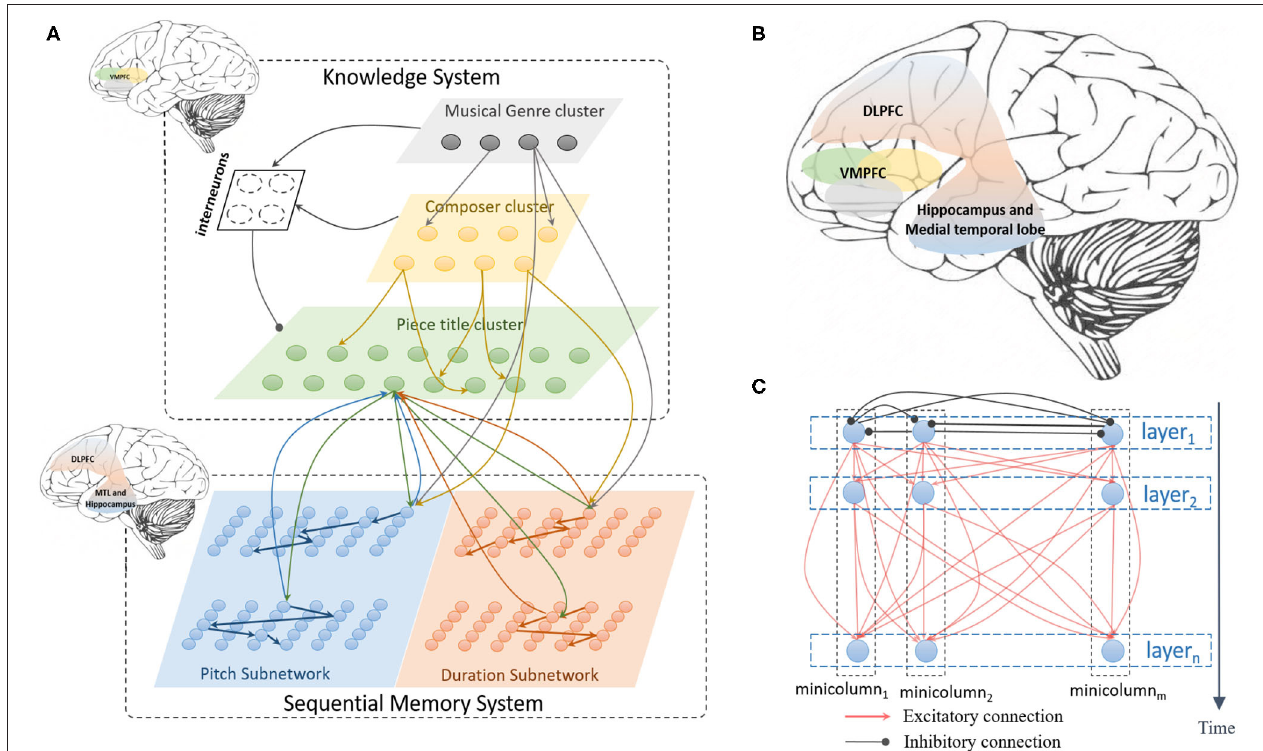
FIGURE 1 | The architecture of the model, (A) describes the total architecture of the model, it contains knowledge and sequential memory subsystems, each subsystem is composed several areas which are inspired by relative brain regions marked in left top, (B) shows the main brain areas related in human memory and creativity, (C) draws the internal connection structure of the pitch and duration subnetworks in sequential memory